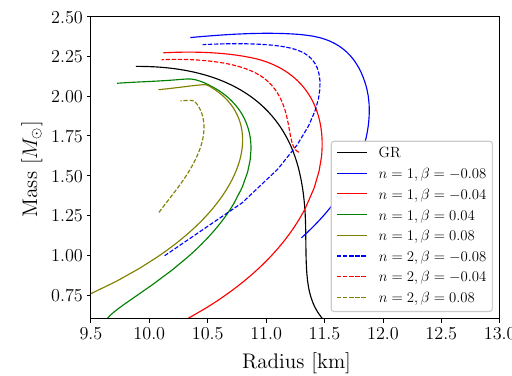
Fig. 1 Mass-radius relations for the APR4 EOS and different values of β for the coupling function (11). n = 1 solutions are shown with solid lines while n = 2 solutions are indicated with dashed lines of the same color